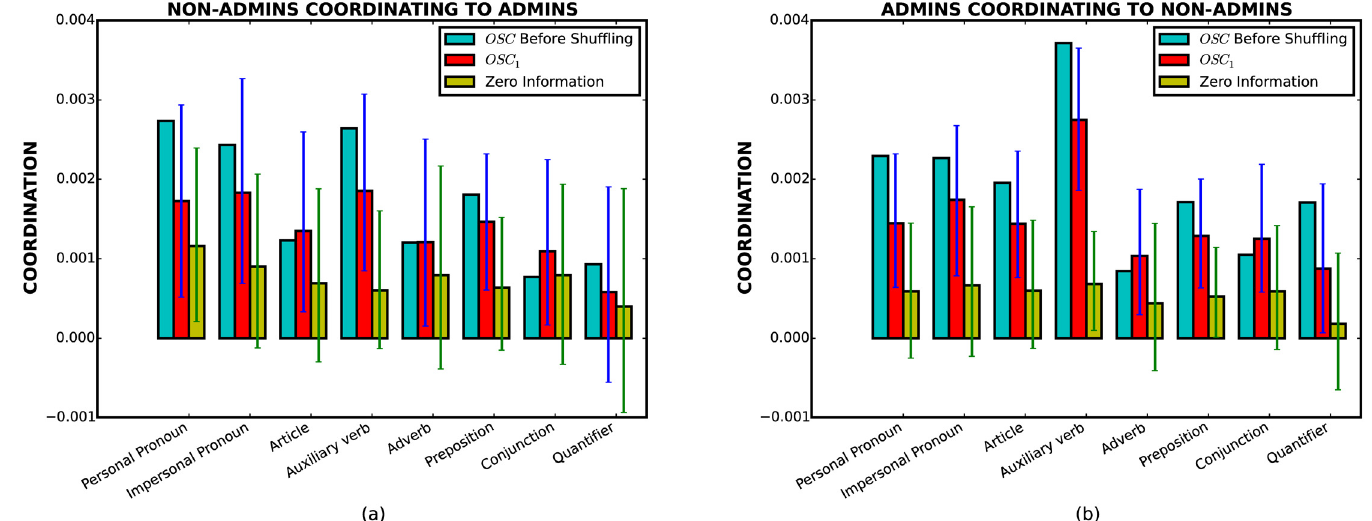
Fig 7. Turn-by-turn stylistic coordination test for Wikipedia data. (a) Non-admins coordinating to Admins. (b) Admins coordinating to Non-admins. (Blue bars indicate the overall stylistic coordination( OSC ) before the test). One cannot rule out the null hypothesis that the remnant stylistic coordination is due to the contextual